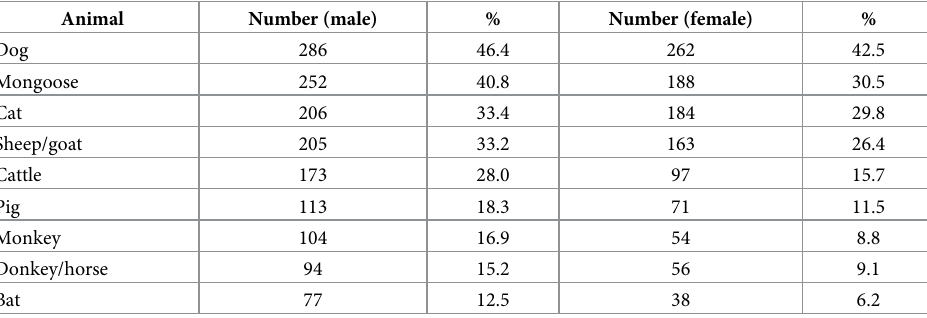
Table 2. Respondents that correctly identified animals susceptible to